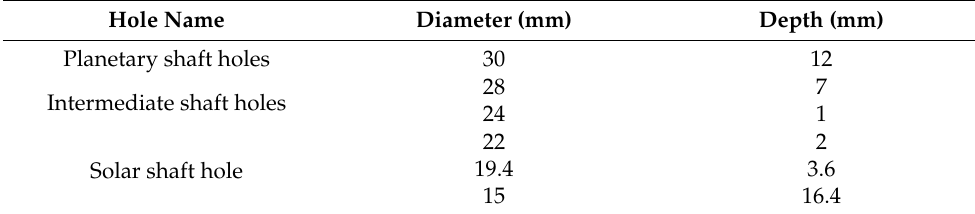
Figure 4. ( a ) Gearbox front view; ( b ) gearbox sectional view; ( c ) gearbox back view. The following parts are shown: 1, planetary shaft holes I; 2, intermediate shaft holes I; 3, solar shaft hole; 4, intermediate shaft holes II; 5, planetary shaft holes II. Table 1. Gearbox shaft hole size.